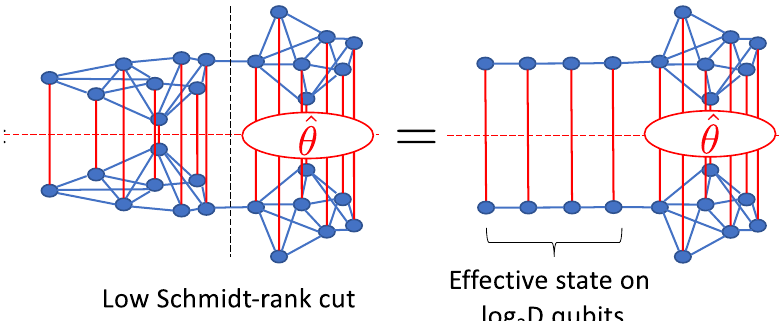
Fig. 1 Tensor network for a quantum state that is weakly entangled across a certain partition. This weak entanglement allows parallel simulation of the two partitions of the system. The expectation of an operator located to the right of the partition can be carried out by replacing the state on the left by a state over much fewer spins (the number determined by the entanglement across the cut). The numerical values of correlations in this smaller representation of the left are determined by quantum effects in the full left-hand system and can be computed in parallel and iterated to